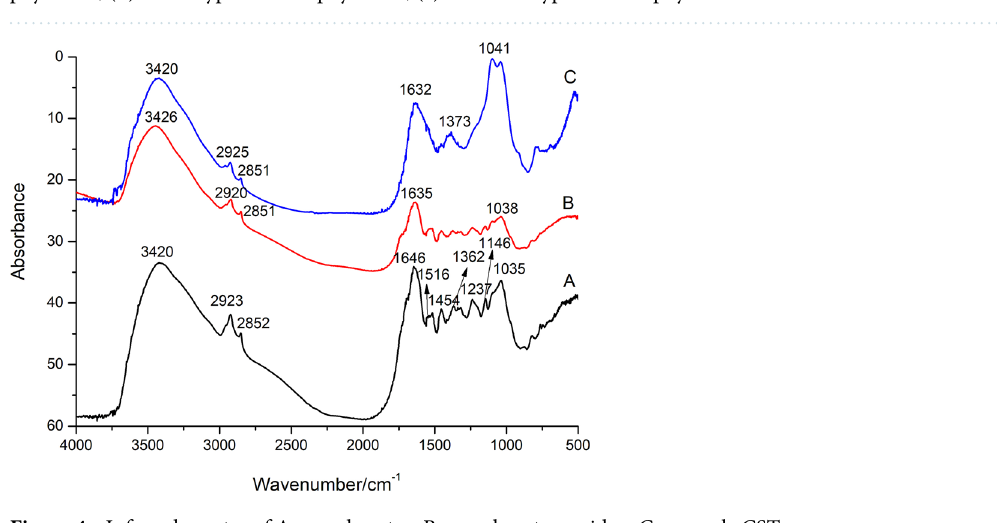
Figure 4. Infrared spectra of A—modern tea; B—modern tea residue; C—sample